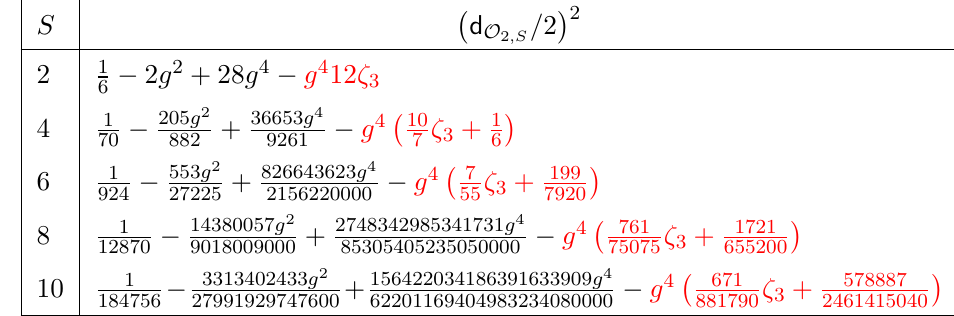
(cid:0) (cid:1) 2 d O = 2 computed from integrability. The num- 2 ;S